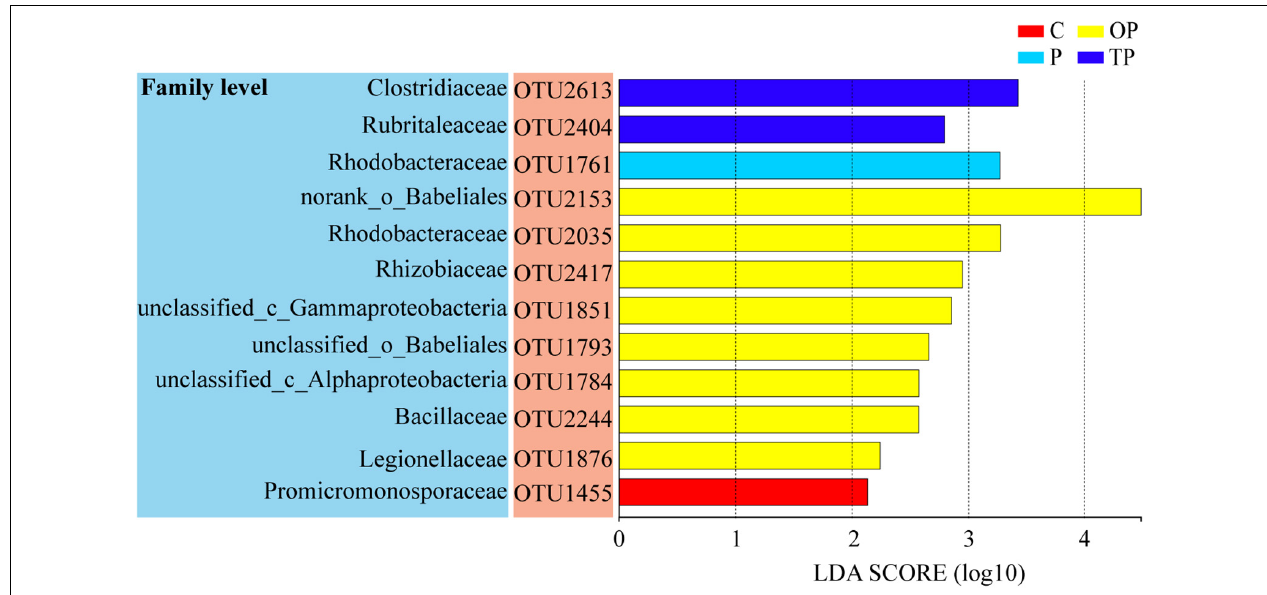
FIGURE 6 | The linear discriminant analysis (LDA) effect size (LefSe) analysis identified the most differentially abundant operational taxonomic units (OTUs) for sea cucumber between the control and PHB treatments. C (control): basal diet; P: basal diet supplementation with 0.5% PHB; OP: basal diet supplementation with 1% PHB; TP: basal diet supplementation with 3%